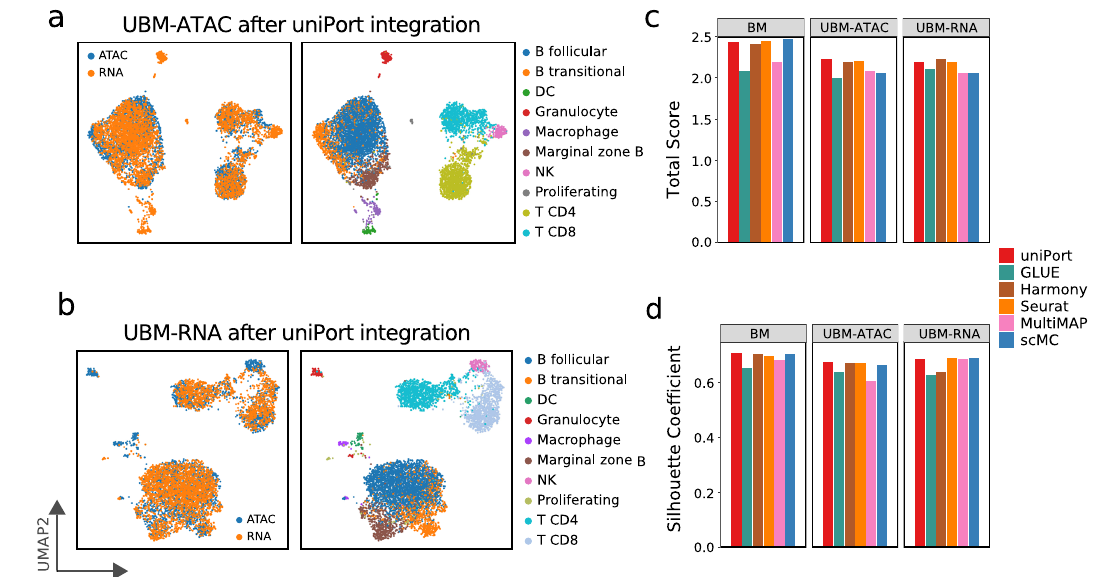
Fig.4|uniPortintegratesthecell-typeunbalancedmousespleendata.a UMAP visualizationofthecaseof “ UBM-ATAC ” afteruniPortintegrationcoloredbyomics and cellannotations. b UMAP visualization of the case of “ UBM-RNA ” after uniPort